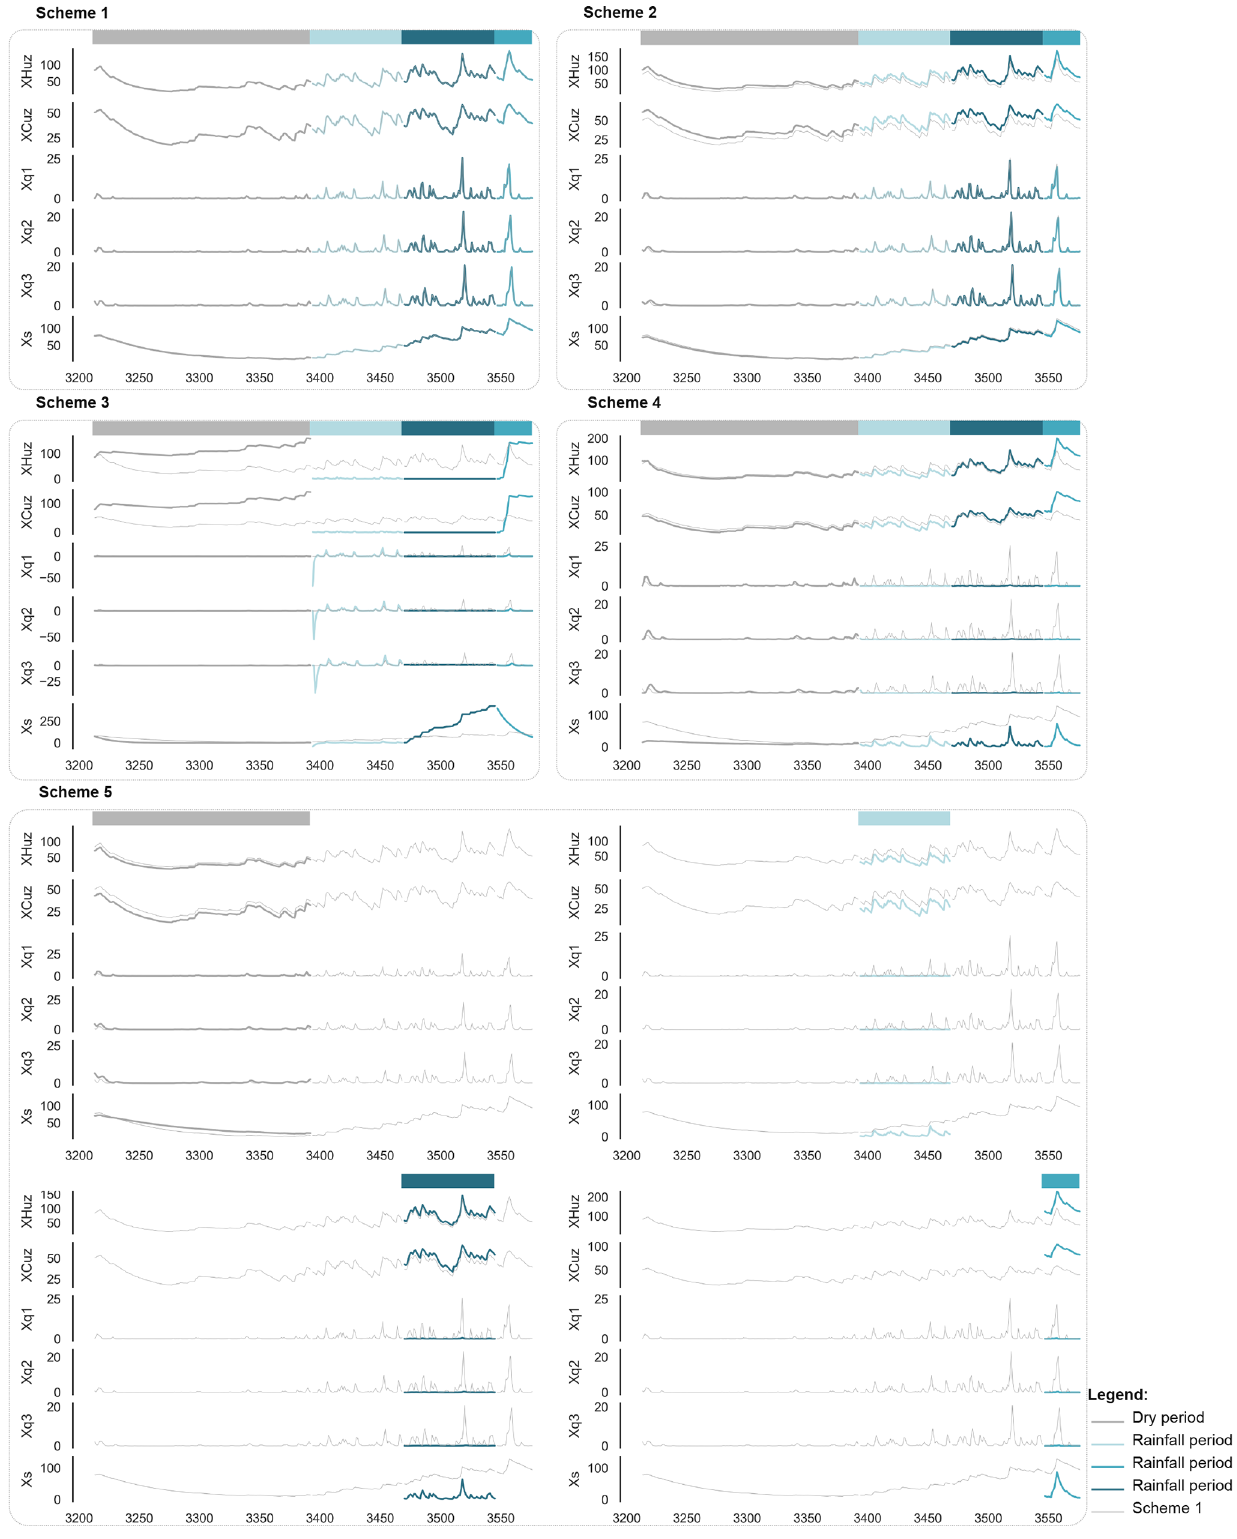
Figure 5. Results of the state variable assessment. The state variables (including XH UZ , XC UZ , X q in the reference year in the validation period in the Hanzhong